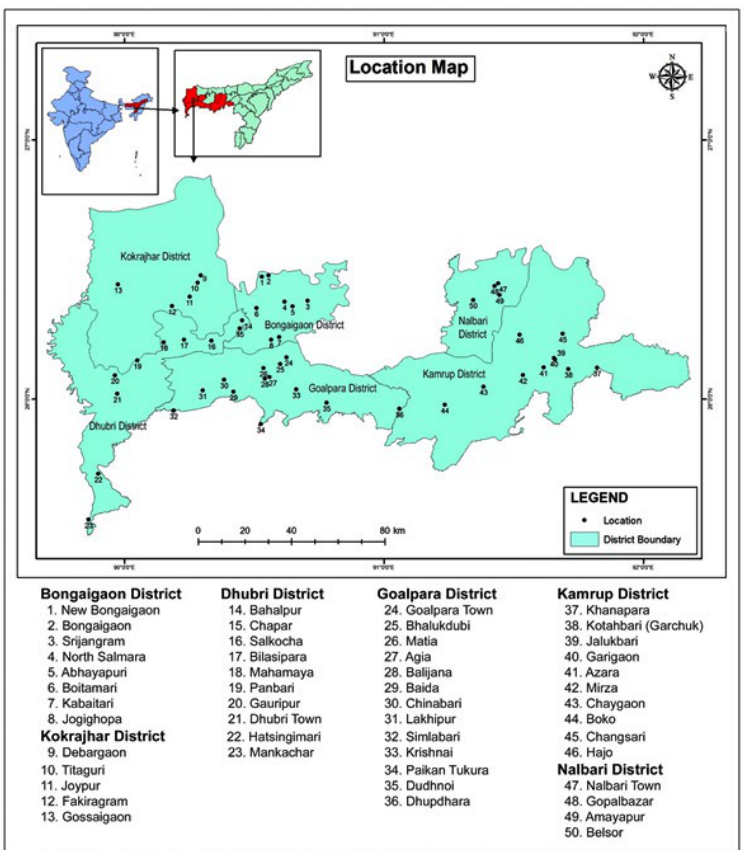
Fig. 1. Representation of sample collection areas developed from GPS coordinates and using GIS software prepared by Aaranyak, Guwahati,